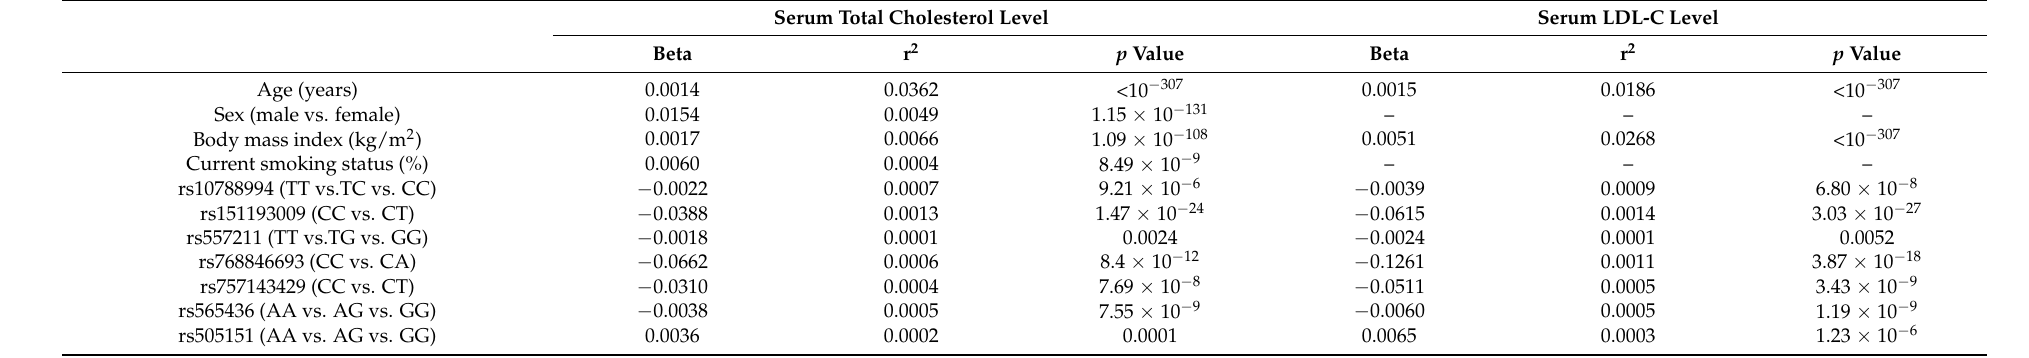
Table 2. Serum total and low-density lipoprotein cholesterol (LDL-C) levels: stepwise linear regression analysis, including PCSK9